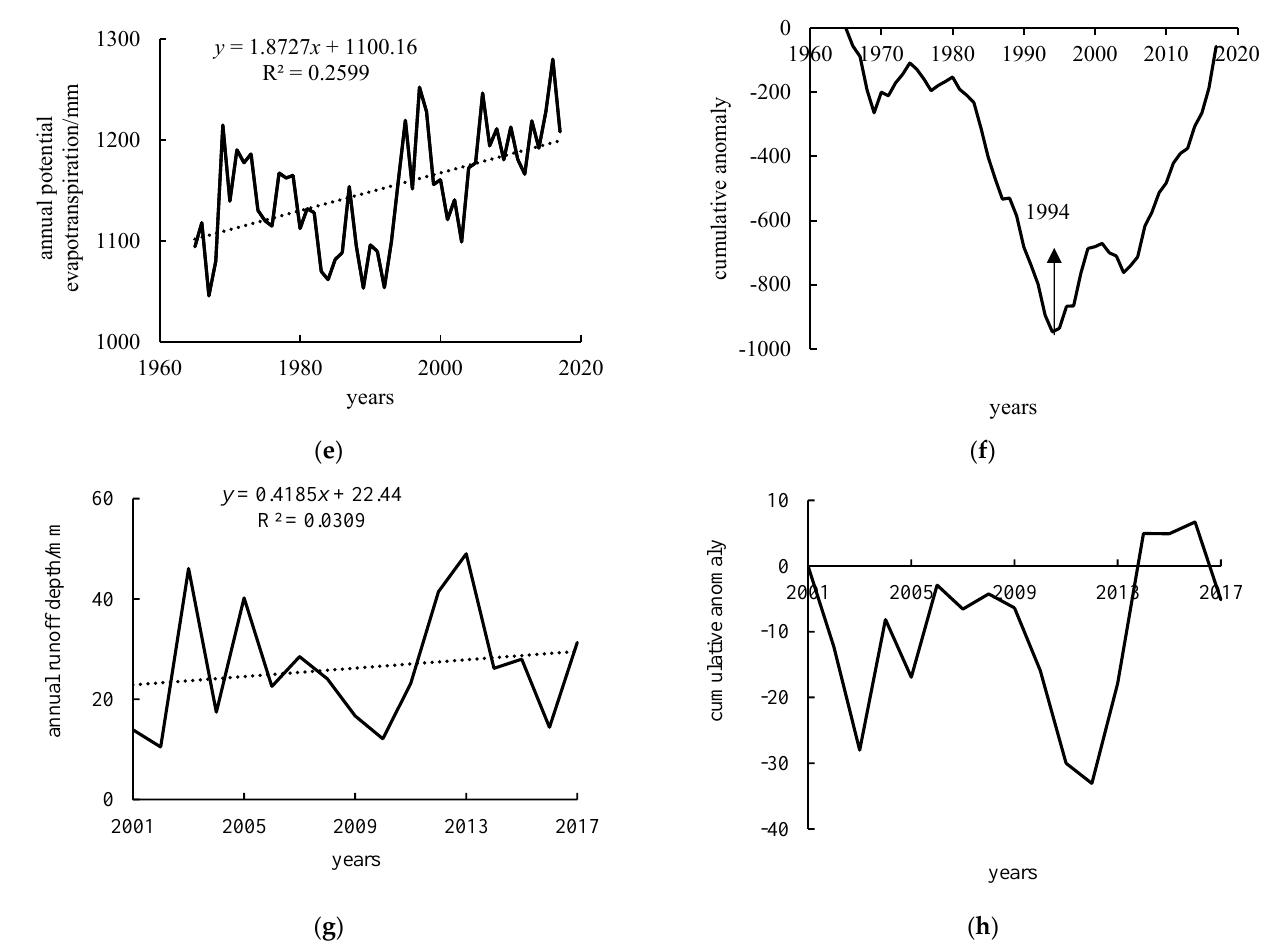
Figure 3. Analysis of trends and abrupt changes of hydrological and meteorological elements in the basin. Note: x = y ear−1964. ( a ) Annual precipitation trend, ( b ) Analysis of abrupt change in annual precipitation, ( c ) Annual temperature trend, ( d ) Analysis of abrupt change in annual temperature, ( e ) Annual potential evapotranspiration trend, ( f ) Analysis of abrupt change in annual potential evapotranspiration, ( g ) Annual runoff depth trend, ( h ) Analysis of abrupt change in annual runoff depth.